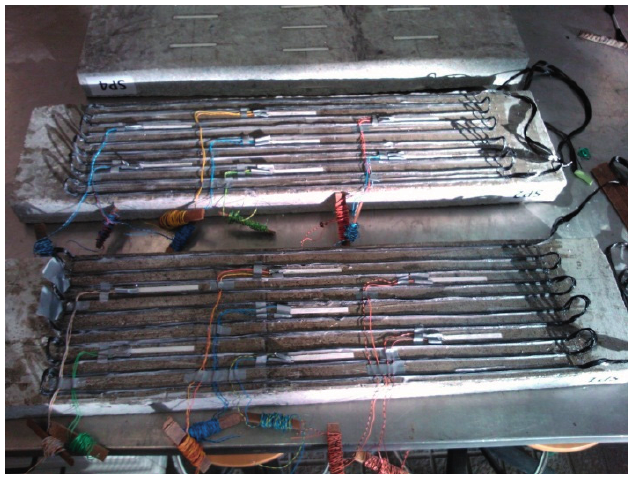
Figure 3. Bottom view of specimens SP1 and SP2—reinforced with Continuous Carbon Fibers Epoxy